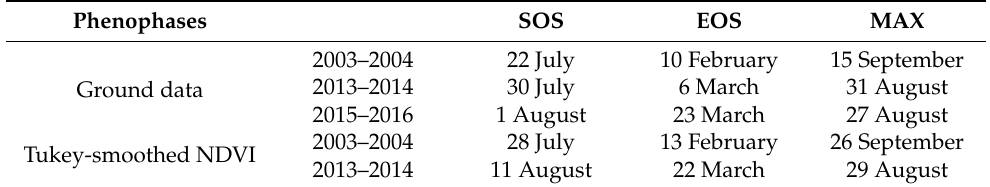
Table 1. Phenological metrics derived using different data at different time periods. Phenophases SOS EOS MAX 2003–2004 Ground data Tukey-smoothed